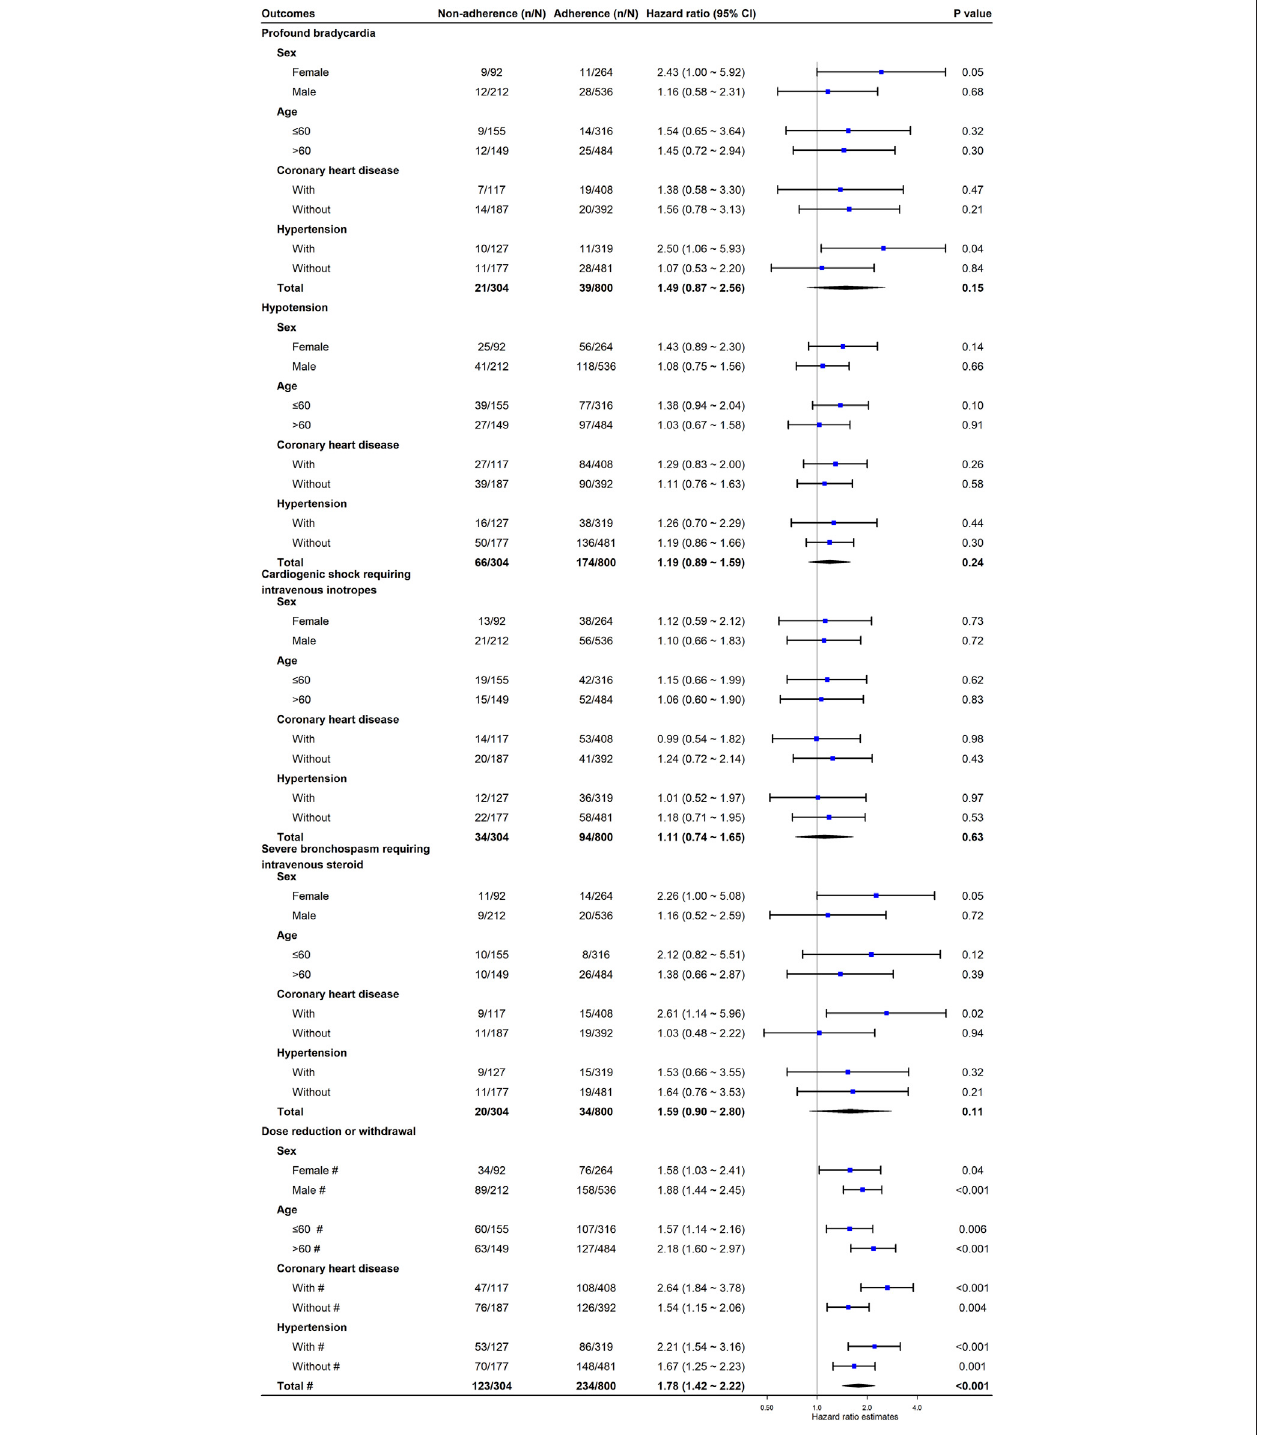
FIGURE 3 | The association between non-adherence to clinical practice guideline recommendations for BB initiation and the risk of adverse events. We derived propensity score for each patient using a multivariable logistic regression model, adjusting for age, sex, baseline heart rate, baseline systolic blood pressure, baseline N-terminal pro-B type natriuretic peptide, baseline left ventricular ejection factor, baseline estimated glomerular fi ltration rate, and Charlson Comorbidity Index. # These hazard ratios are derived from accelerate failure time model with Weibull distribution; others are derived from Cox proportional hazards regression model with inverse probability weighting. * The P interaction < 0.05. Abbreviations: CI, con fi dence interval; N, number of patients in each group; n , number of events in each group.